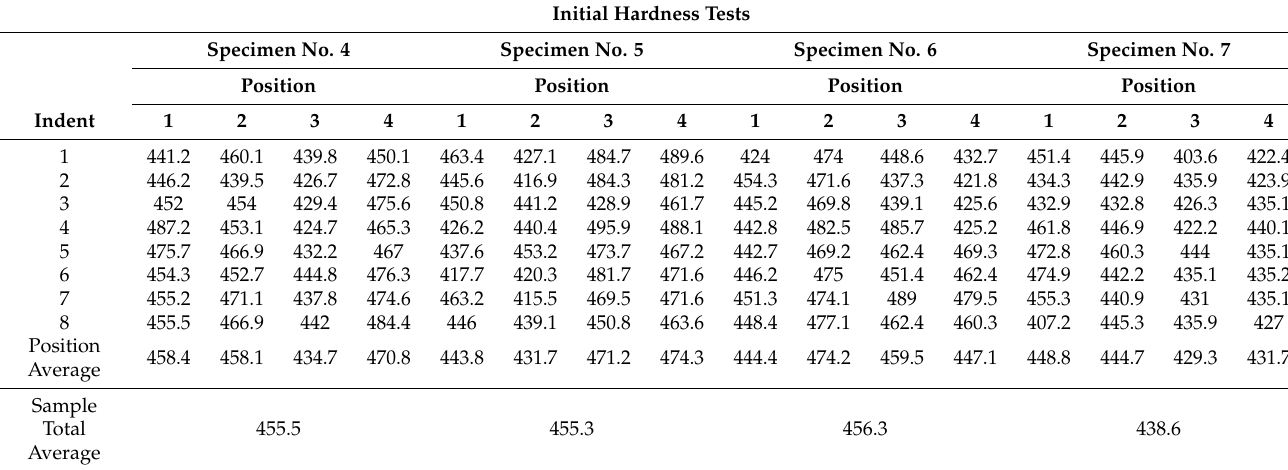
Table A2. Hardness tests of specimens No. 4-7 vertically